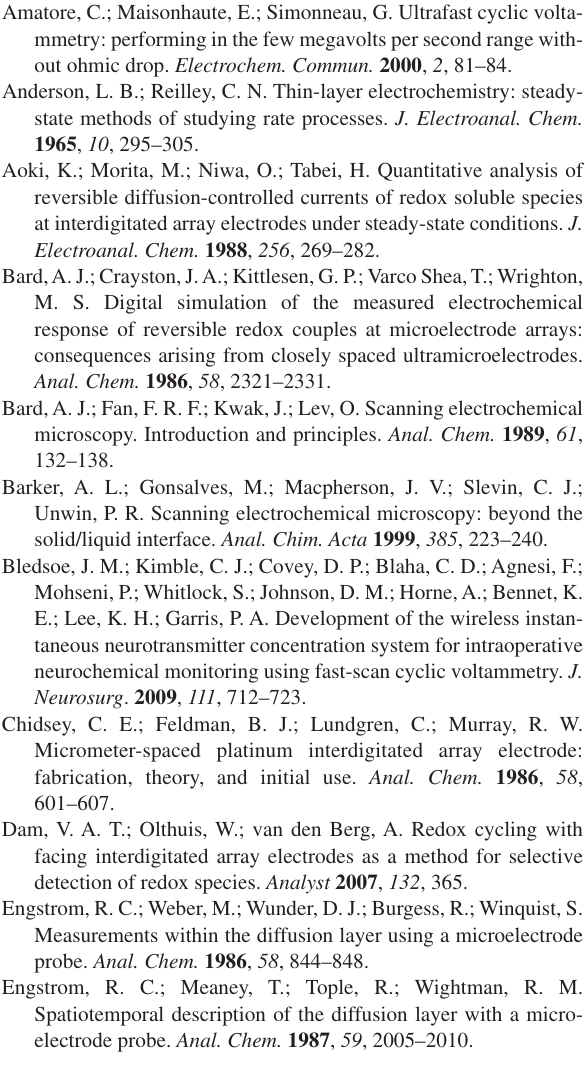
Figure 5 Illustration of the fabrication process of a nanocavity redox cycling sensor in a cross-section view. The sketch shows the individual production steps, i.e., the deposition of the bottom elec- trode (A), the sacrifi cial layer (B), the top electrode (C), and the passivation layer after the anisotropic etch (D). The last illustration depicts the fi nal sensor after the removal of the sacrifi cial layer